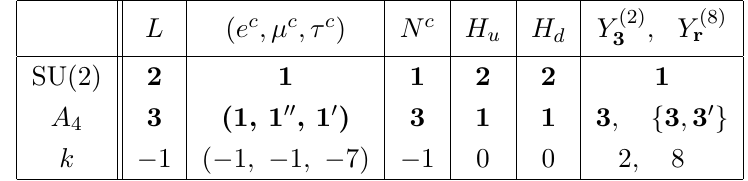
Table 5 . Representations and weights k for MSSM fields and modular forms of weights 2 and 8